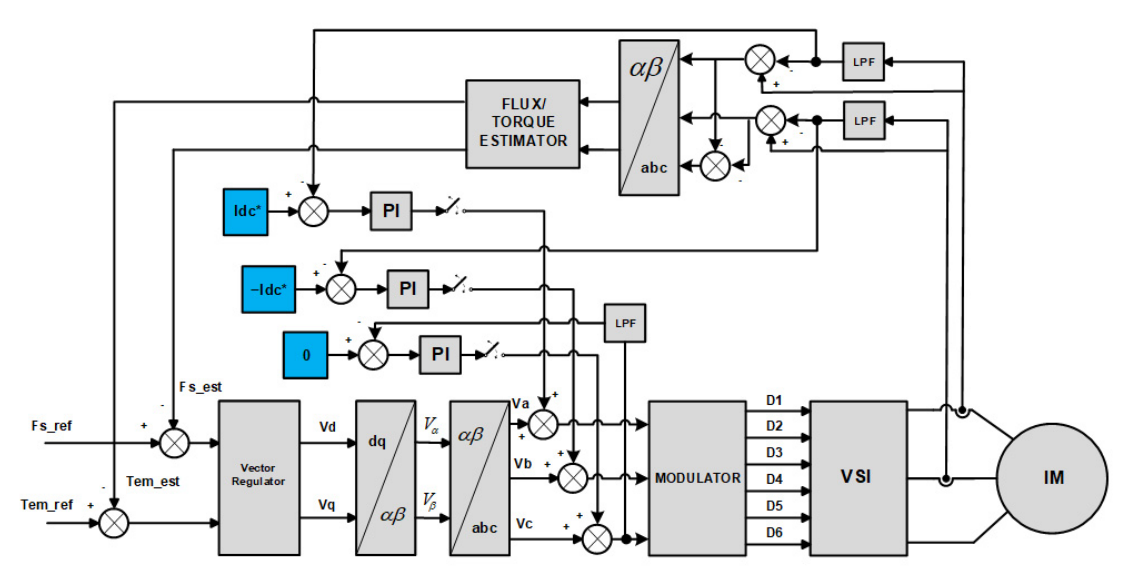
Figure 1. Closed loop vector control with injection algorithm.